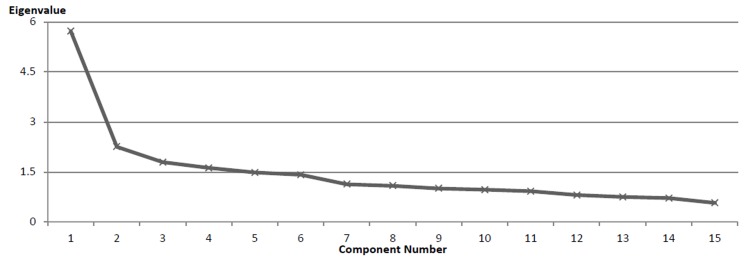
Screen plot of PCA eigenvalues for the SMMS-R-FR